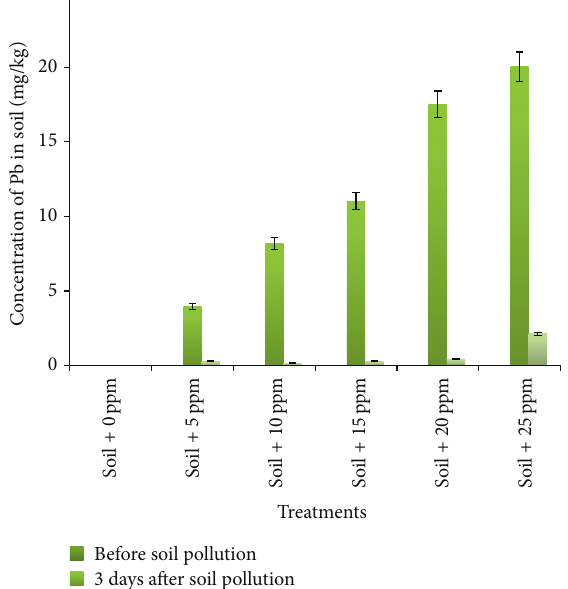
Figure 1: Concentration of Pb in polluted soil remediated with G. max L.